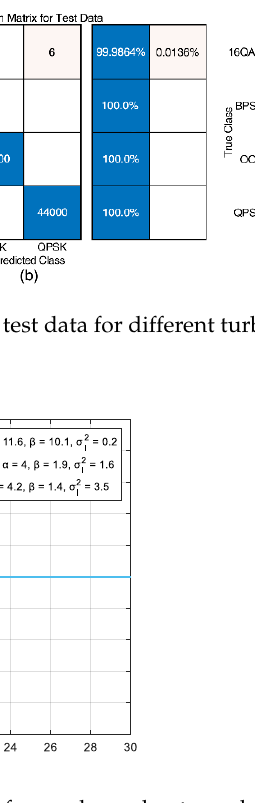
Figure 11. SNR vs. test accuracy for weak, moderate, and strong turbulence strength.